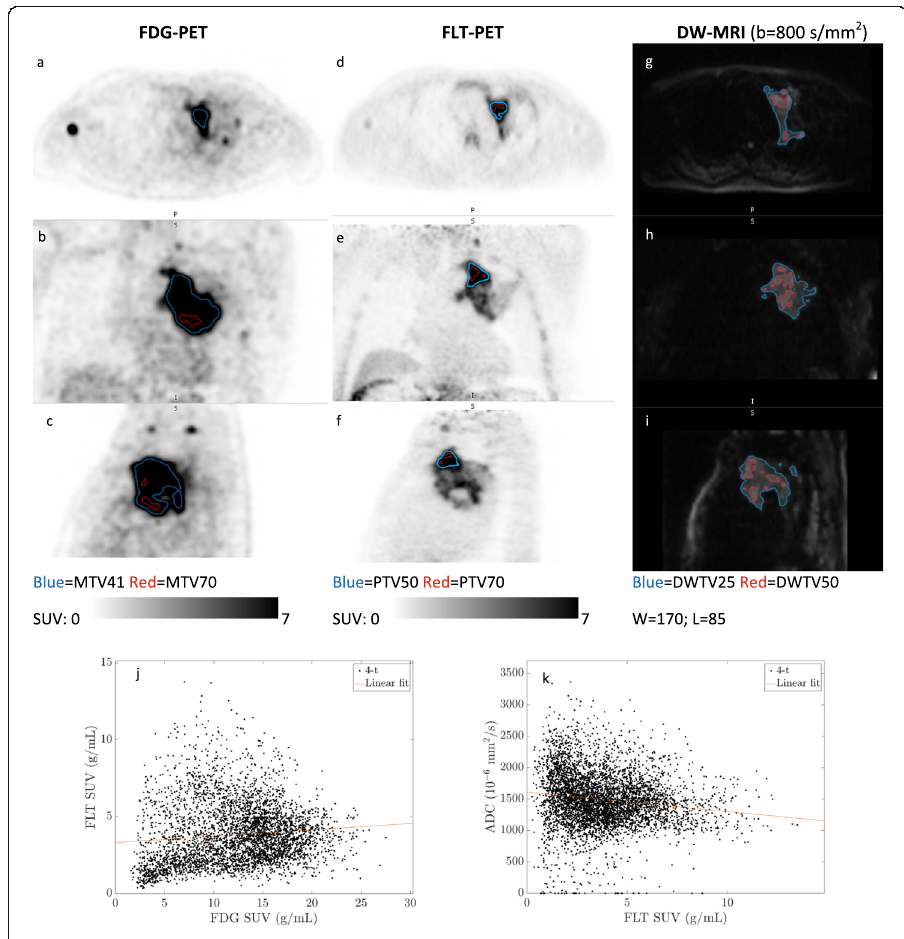
Fig. 3 T-site (4-T) with high and heterogeneous FLT-uptake: FDG-PET (axial ( a ), coronal ( b ), sagittal ( c )), FLT- PET (axial ( d ), coronal ( e ), sagittal ( f )), and DW-MRI (transversal ( g ), coronal ( h ), sagittal ( i )), and voxel-by-voxel scatterplot of FDG-SUV vs. FLT-SUV ( j ) and FLT-SUV vs. ADC ( k ). This lesion was clearly detectable on FDG-PET (SUV peak 22.7), detectable but very heterogeneous on FLT-PET (SUV peak 11.5), and detectable on DW-MRI (ADC median 1.43× 10 − 3 mm 2 /s). The most metabolically active region (MTV70) was located caudally, whereas the most proliferative active region (PTV70) was located cranially within the tumor, thus MTV70 and PTV70 showed no overlap. The most water- diffusion restricted regions (DWTV50) were randomly distributed and overlapped partially with both MTV70 and PTV70. The voxel-by-voxel scatter plots ( j , k ) showed very weak overall correlations. This T-site had no change as response to